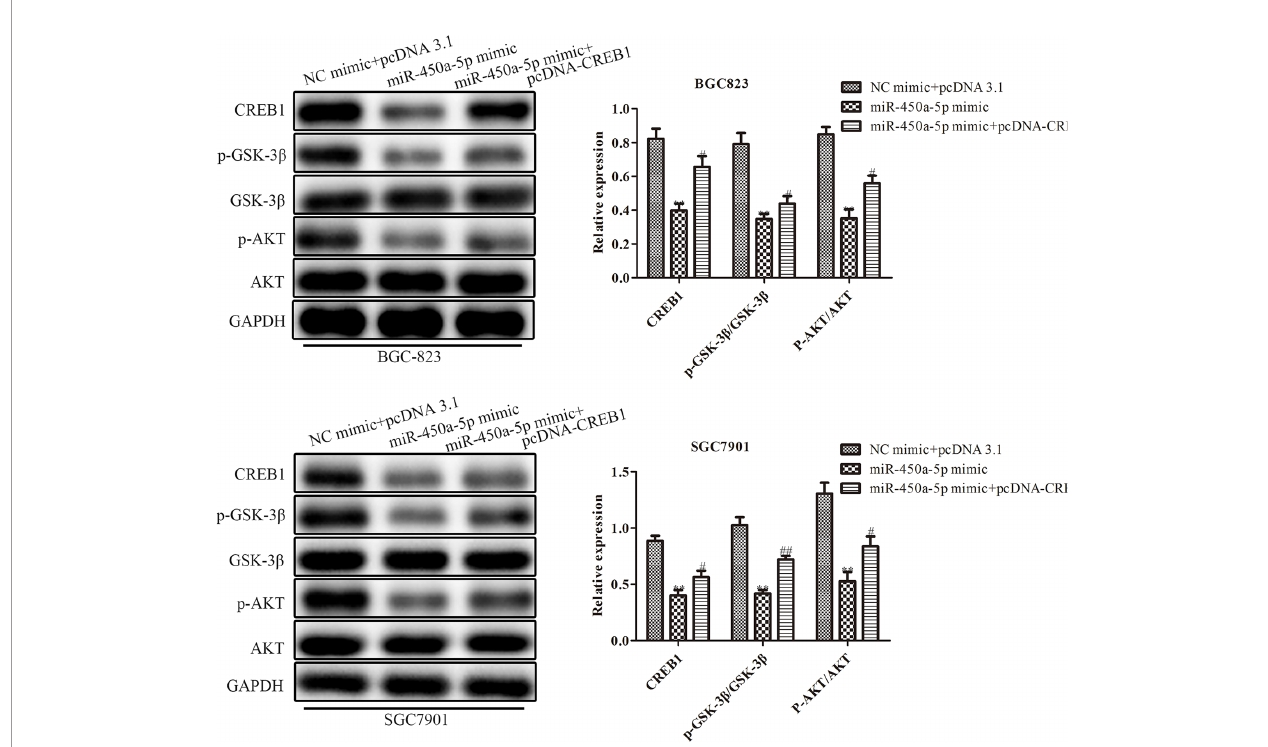
FIGURE 7 | MiR-450a-5p regulates the AKT/GSK-3 b signaling pathway. Western blotting evaluated the protein expression of CREB1, GSK-3 b , AKT, p-GSK-3 b , p-AKT. ** P <0.05 vs. NC + pcDNA3.1 group. # P <0.05, ## P <0.01 vs. miR-450a-5p mimic